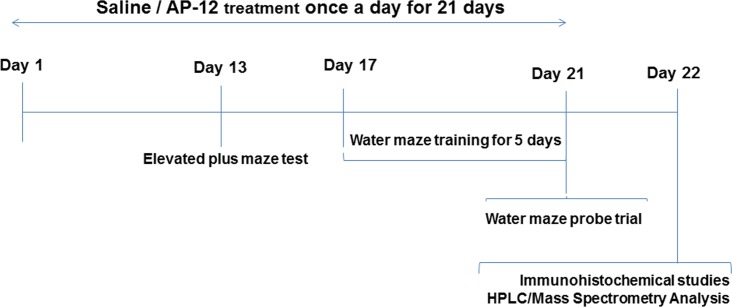
Experimental design.